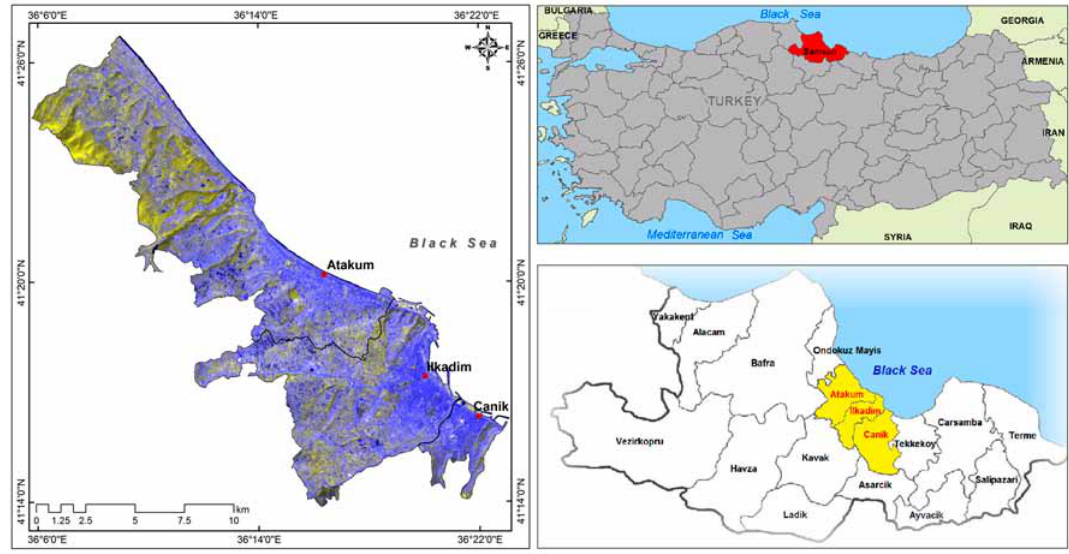
Fig. 1. Location of the study area: the Atakum, Ilkadim and Canik Districts are in the Black Sea Region,